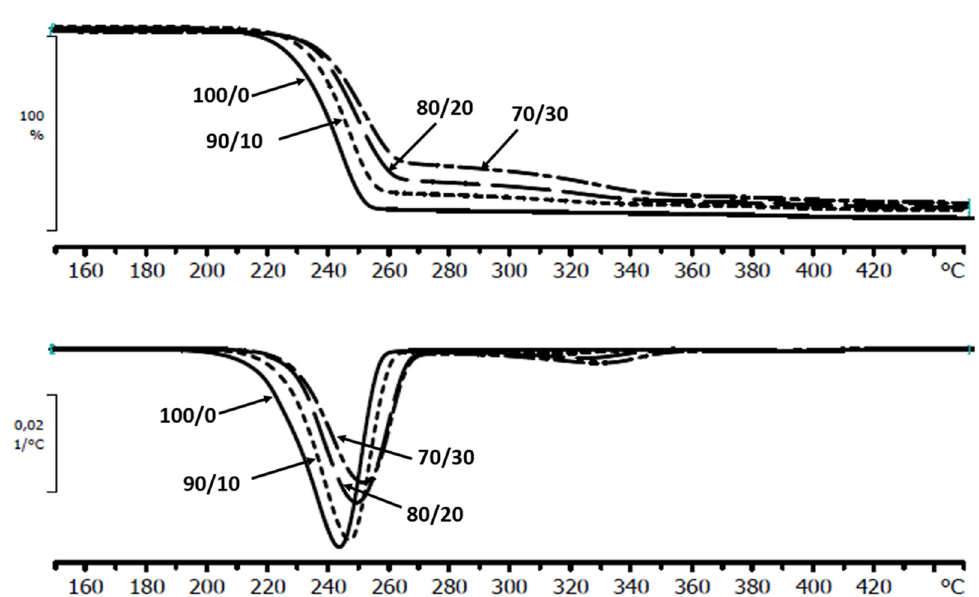
Figure 2. Thermal decomposition (TG) curves and their first-order derivative (DTG) curves of the neat P(3HB- co -4HB) (100 / 0) and P(3HB- co -4HB) / WF composites with the mass ratio of 90 / 10, 80 / 20, and 70 / 30, before degradation.